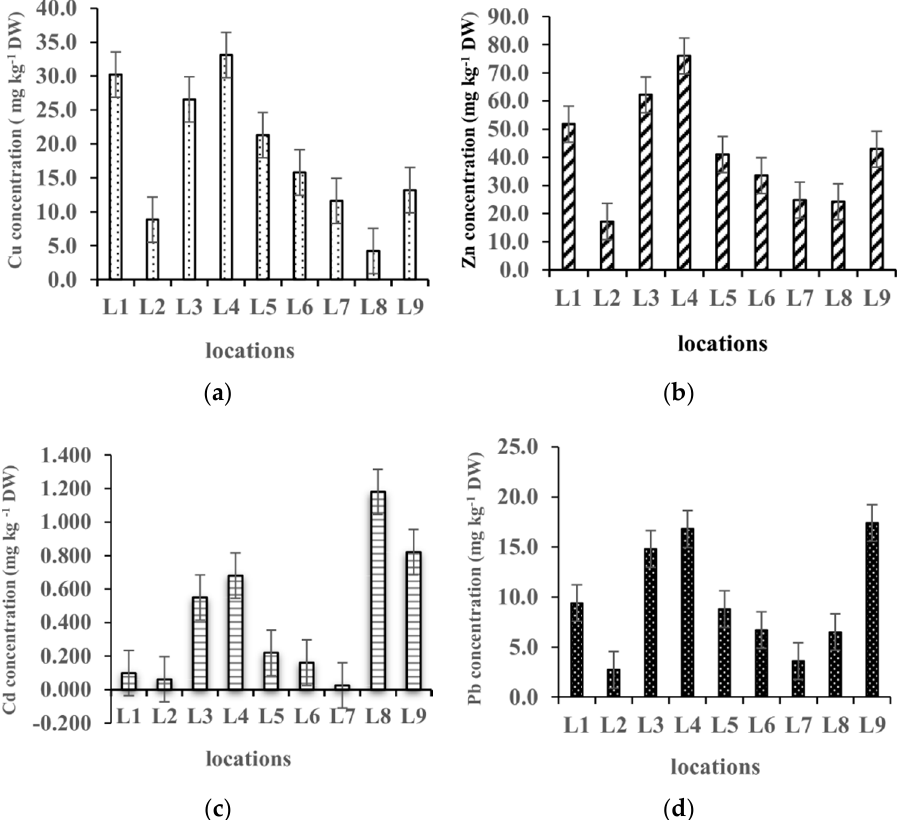
Figure 1. Concentrations of Cu ( a ), Zn ( b ), Cd ( c ), and Pb ( d ) in the sediment samples from different locations.